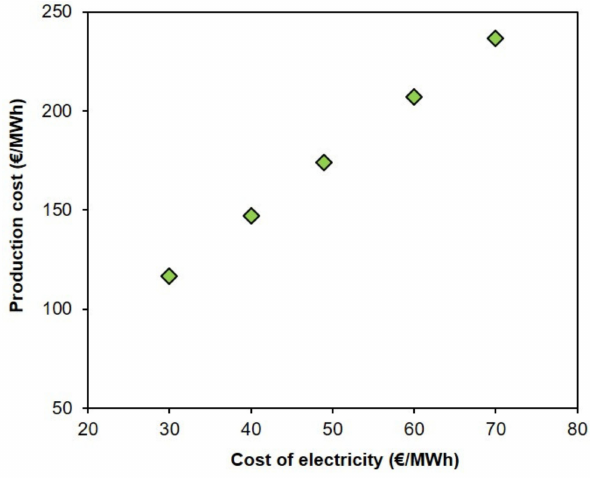
Figure 6. Effects of varying the cost of electricity on the fuel production